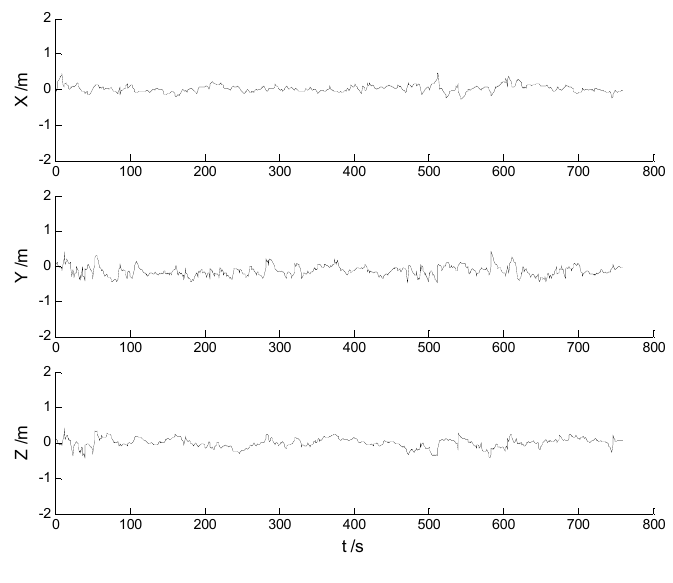
Figure 5. Position errors of the NMF-CKF algorithm.